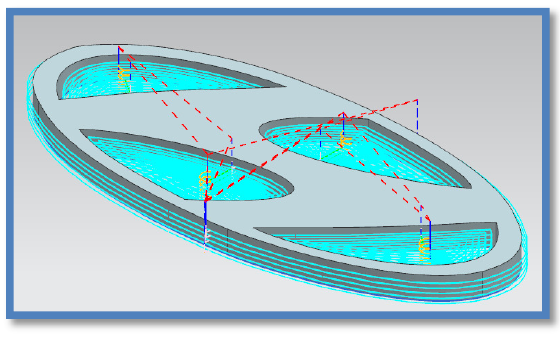
Fig. 5. Continuity example for curves of C 0 Bezier curve.